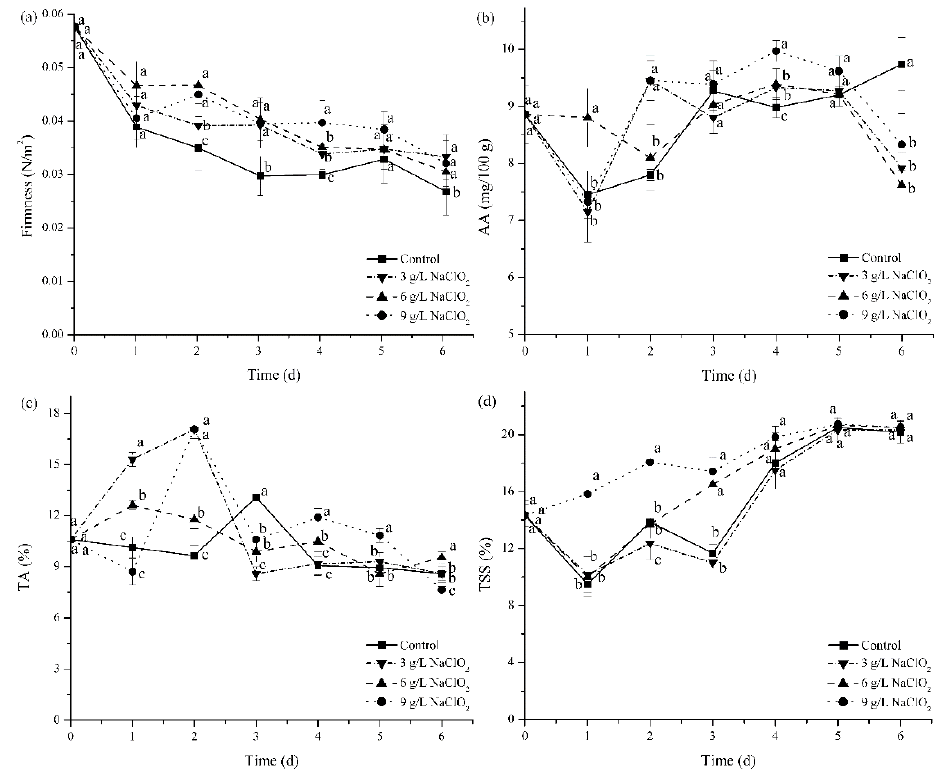
Figure 5. Firmness ( a ), AA content ( b ), TA content ( c ) and TSS content ( d ) of strawberries packed in different corrugated cardboard boxes during storage at room temperature. Means of different samples with different letters (a, b, c) on the same day of storage were significantly different ( P > 0.05).